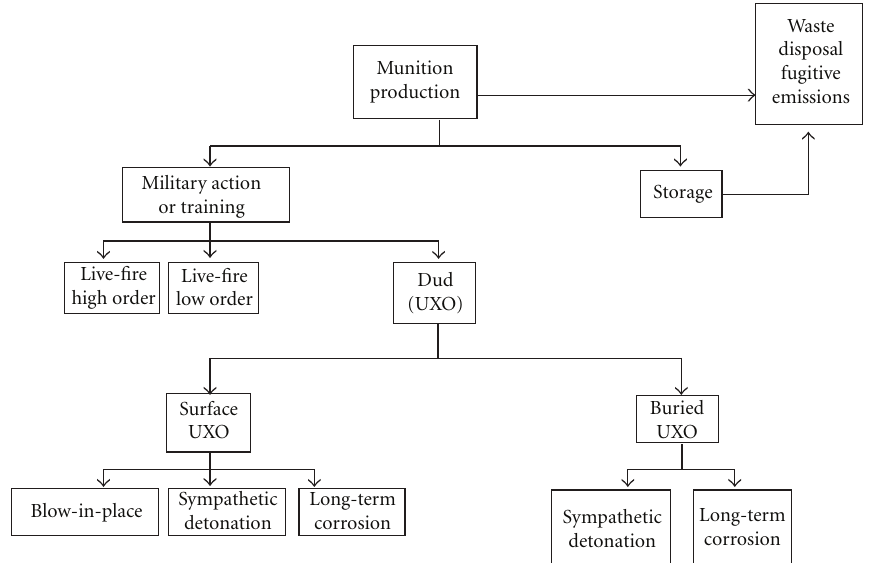
Figure 2: Possible fates of explosives. (Adapted from [33,